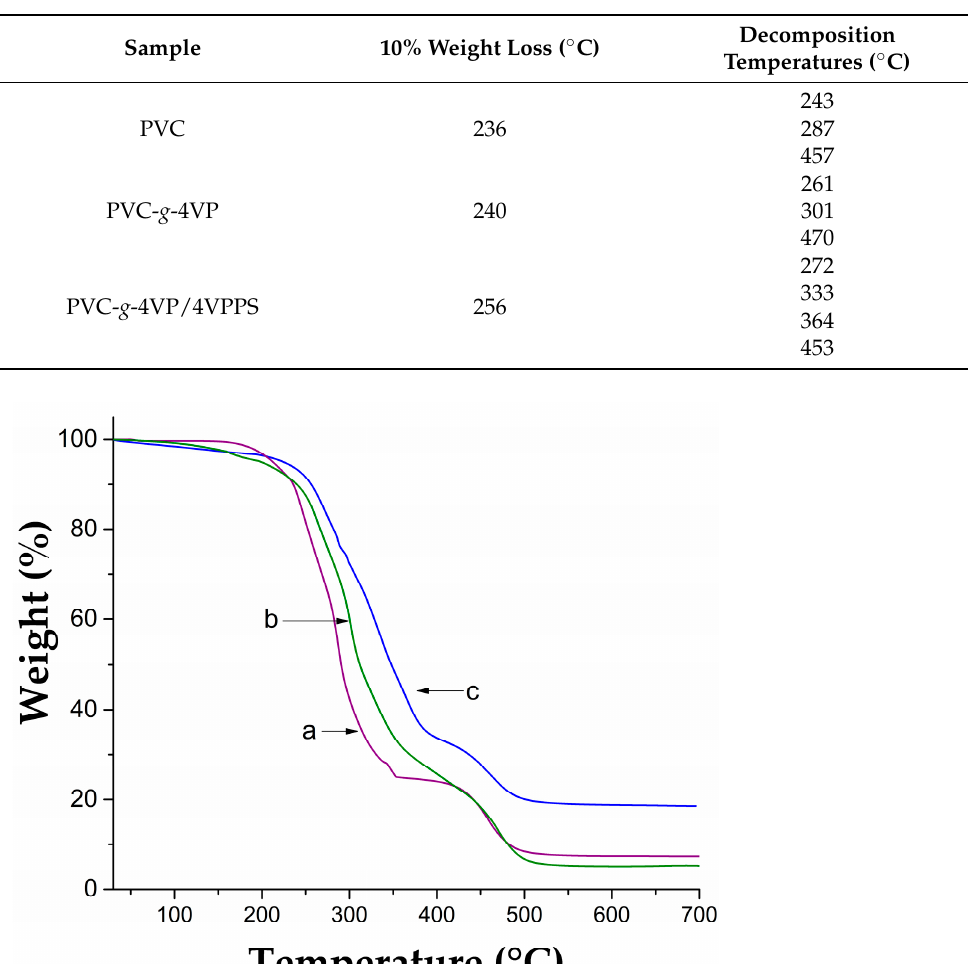
Table 2. Thermogravimetric analysis.